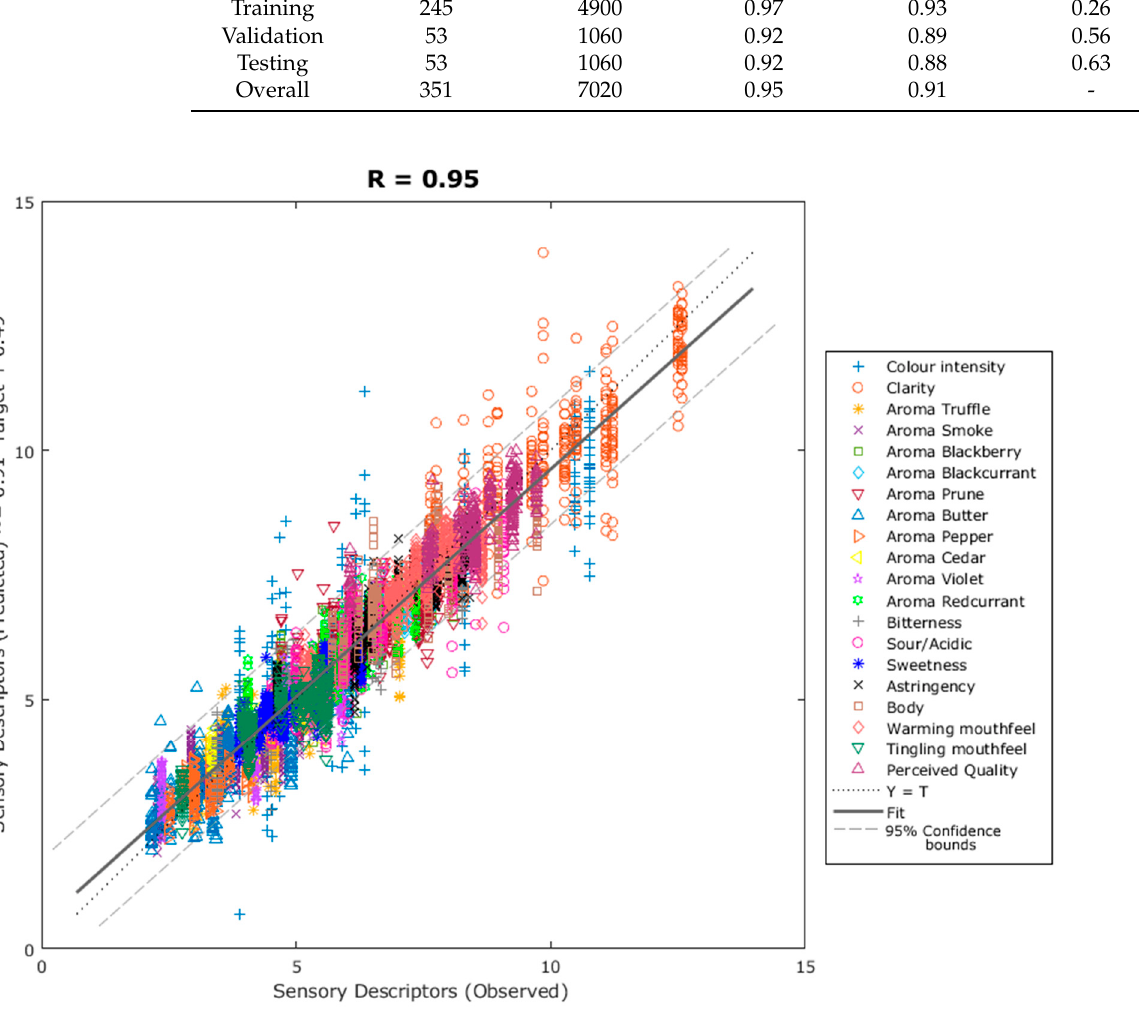
Figure 6. Overall machine learning model to predict sensory descriptors using NIR absorbance values measured through the bottles as inputs.